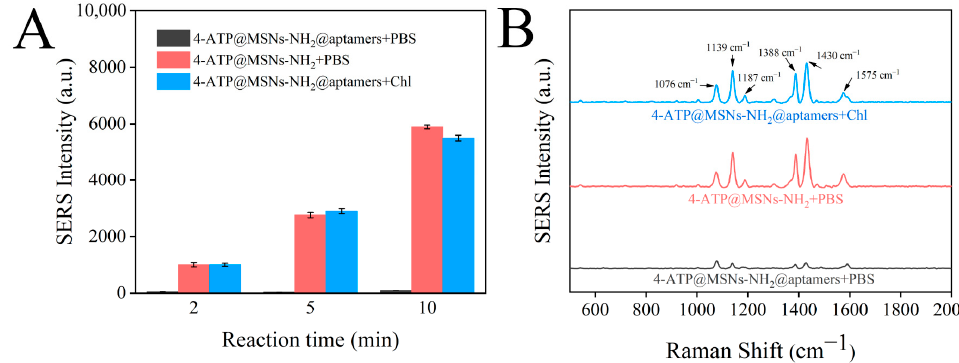
Figure 7. Changes in the SERS intensities of 4-ATP@MSNs-NH 2 , 4-ATP@MSNs-NH 2 @aptamers, and 4-ATP@MSNs-NH 2 @aptamers + chlorpyrifos with time ( A ); SERS spectrum of 4-ATP@MSNs-NH 2 ,